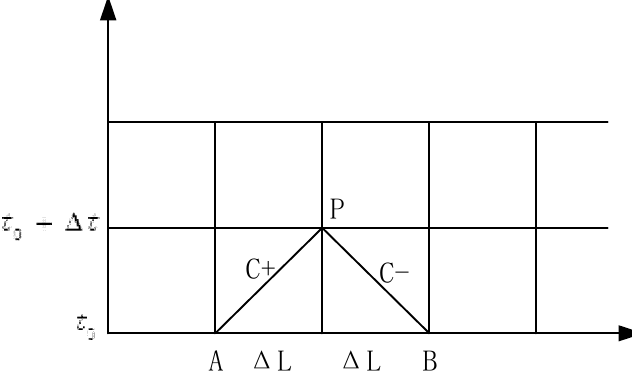
Figure 2. Characteristic lines in L- t plane of MOC.